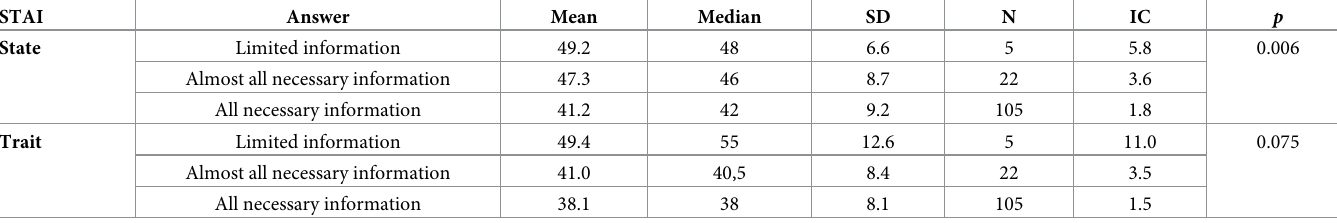
Table 3. Comparison between anxiety levels (assessed by STAI) and information previously provided by the referring physician. Respondents were asked the follow- ing question: "Do you believe that the referring doctor provided all the necessary information to you prior to your procedure?". STAI